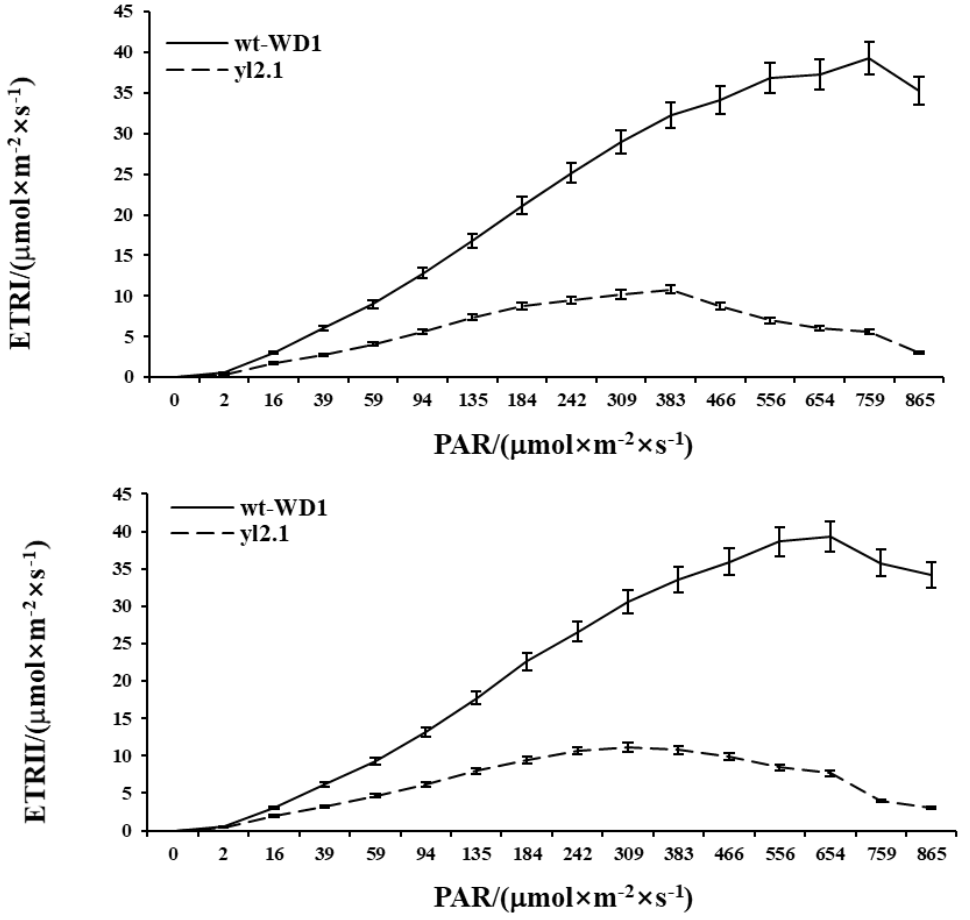
Figure 6. The PSI and PSII rapid light curve of yl2.1 and wt-WD1. For each sample, five independent biological replications were performed. Each independent biological replication contains three different individuals. Three technical repeats were performed for each biological replication. The average of the three technical repeats was used as the data of one biological replication. Data are means ± SD ( n = 5). ETRI indicated the rate of relative photosynthetic electron transport of photosystem I. ETRII indicated the rate of relative photosynthetic electron transport of photosystem II. PAR indicated photosynthetical active radiation.